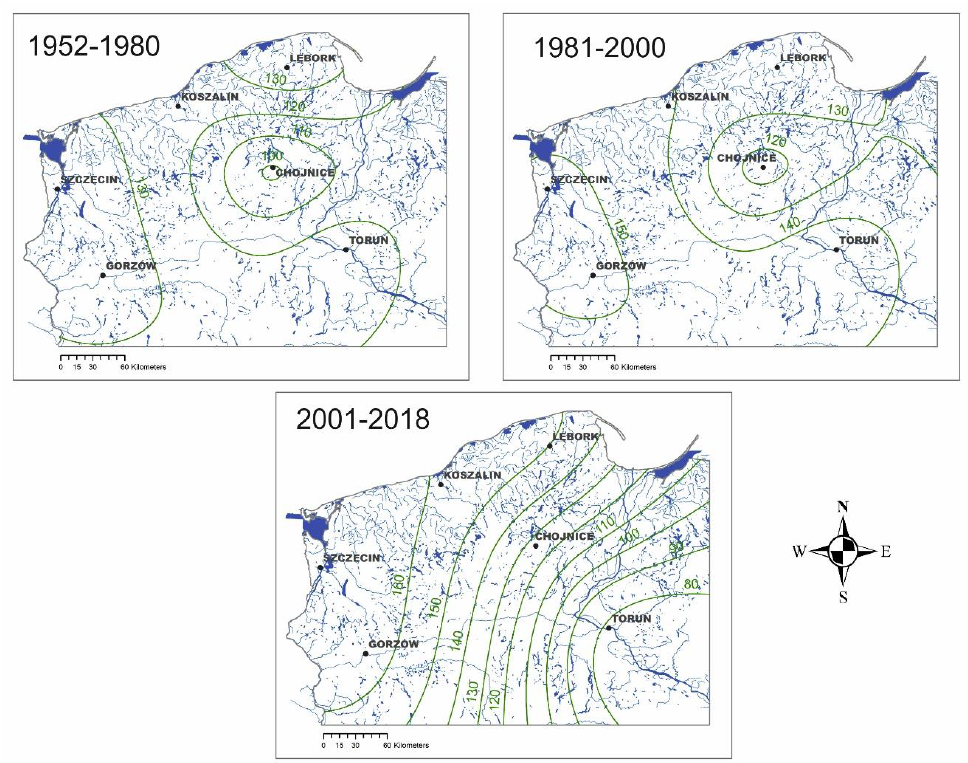
Figure 8. Spatial distribution of average winter half-year (XII–III) sums of potential evaporation in north-western Poland divided into the periods 1952–1980, 1981–2000 and 2001–2018 against the distribution of the water network (calculated based on data obtained from the Polish Institute of Meteorology and Water Management—National Research Institute [43], water network based on [41]).